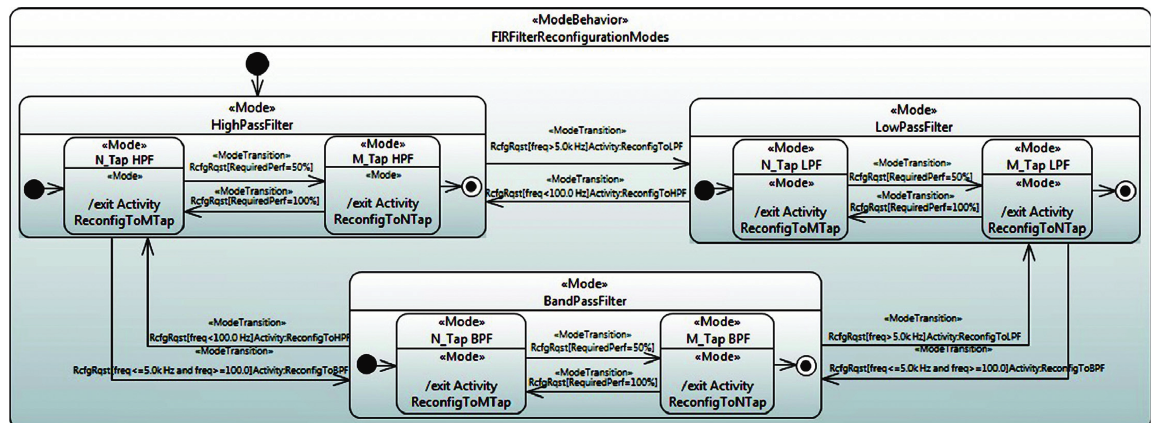
Figure 15: Filter structural/behavioral